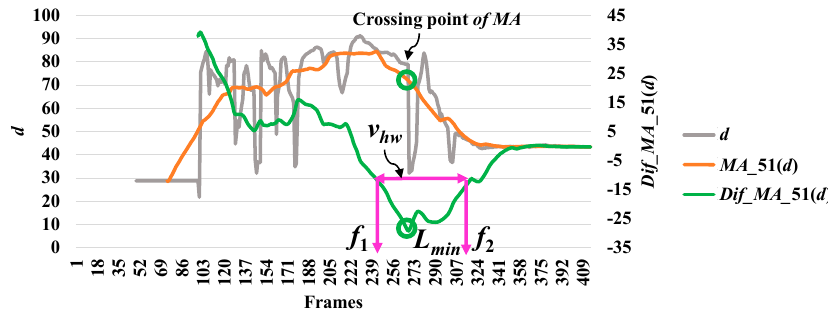
Figure 4. Analysis for a high possibility of abnormal (falling) points based on the point distance ( d ).